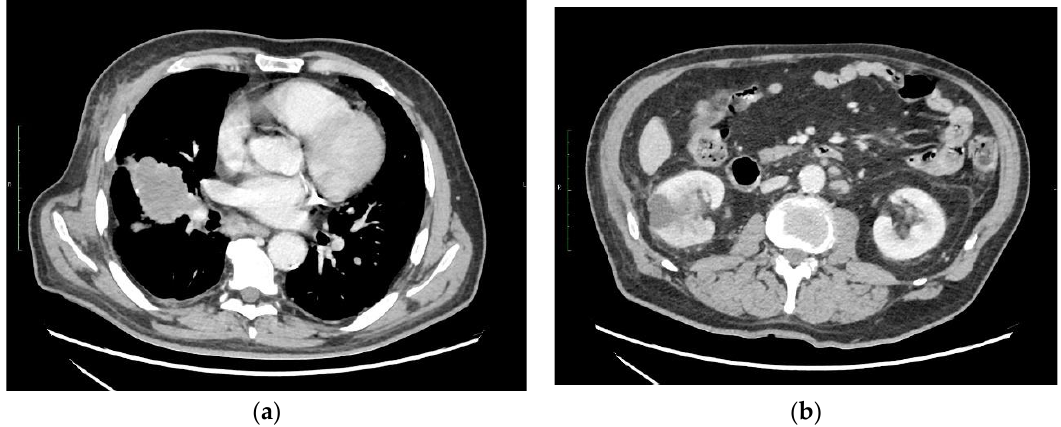
Scheme 1. Computed tomography showing the tumors of the apex of the right lung with metastases to mediastinal and hilar lymph nodes ( a ) as well as a metastatic lesion in the right kidney ( b